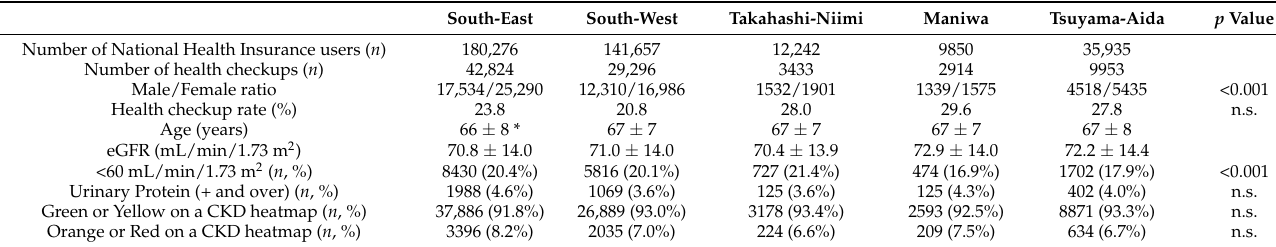
Table 1. Health checkup ratio and severity of CKD.